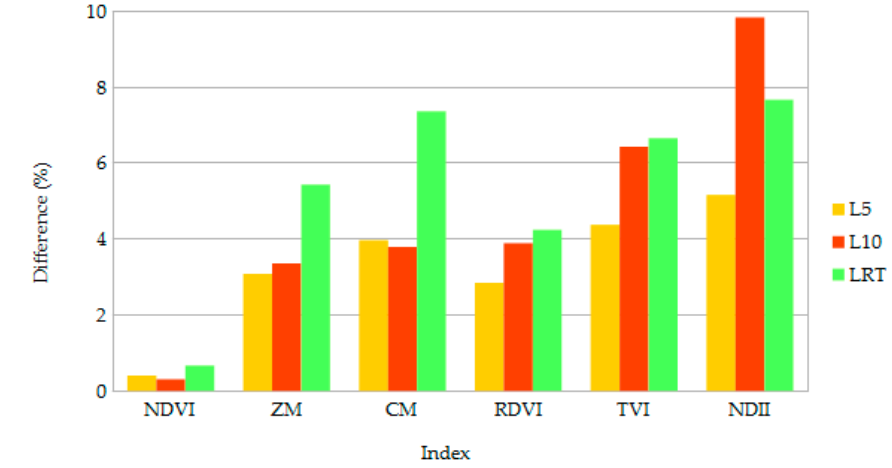
Figure 4. Percentage difference of calculated vegetation indices for three different canopy configurations. Leaf area index reduced by 5% and 10% (L5 and L10, respectively), and LR with modified LAD distribution (LRT).